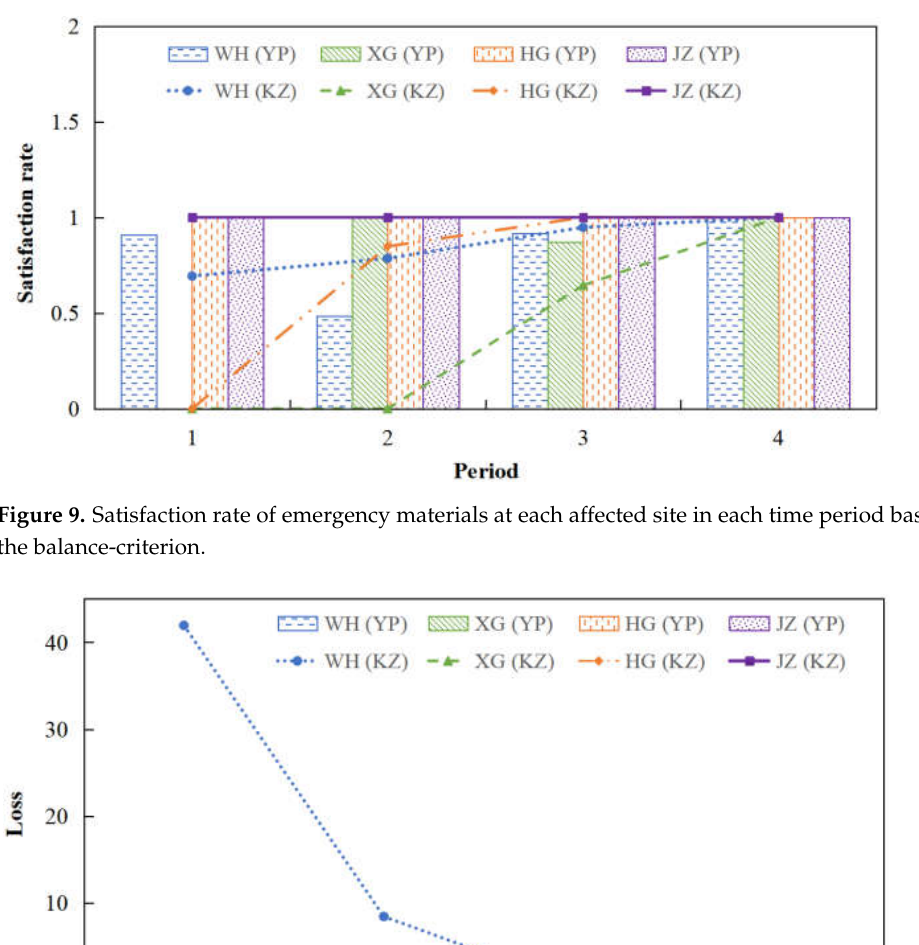
Figure 8. Cost of obtaining emergency materials at each affected site in each time period based on the balance-criterion.